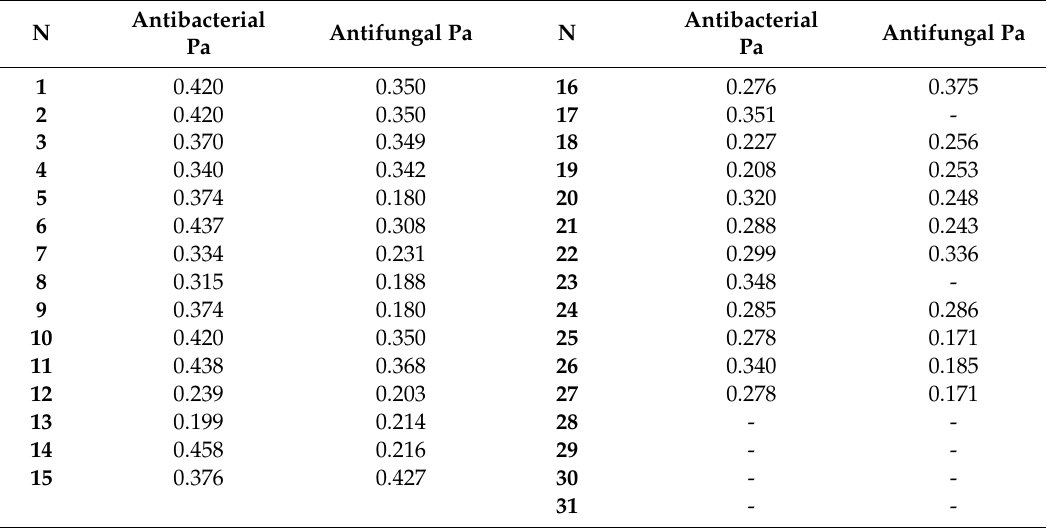
Table 2. Predicted biological activity spectra for the studied